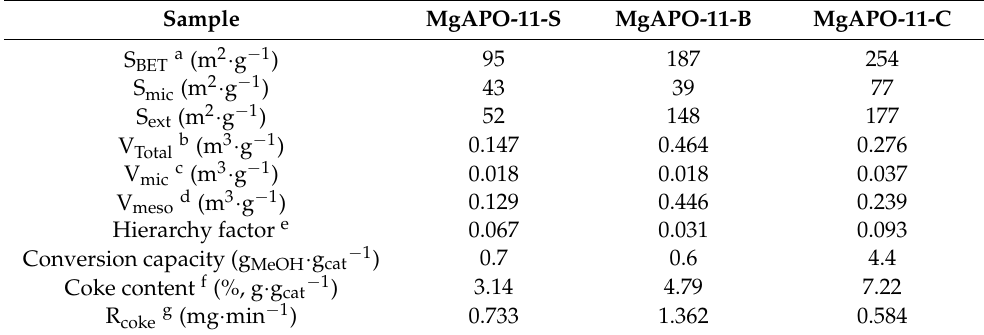
Table 2. Characterization data of the MgAPO-11